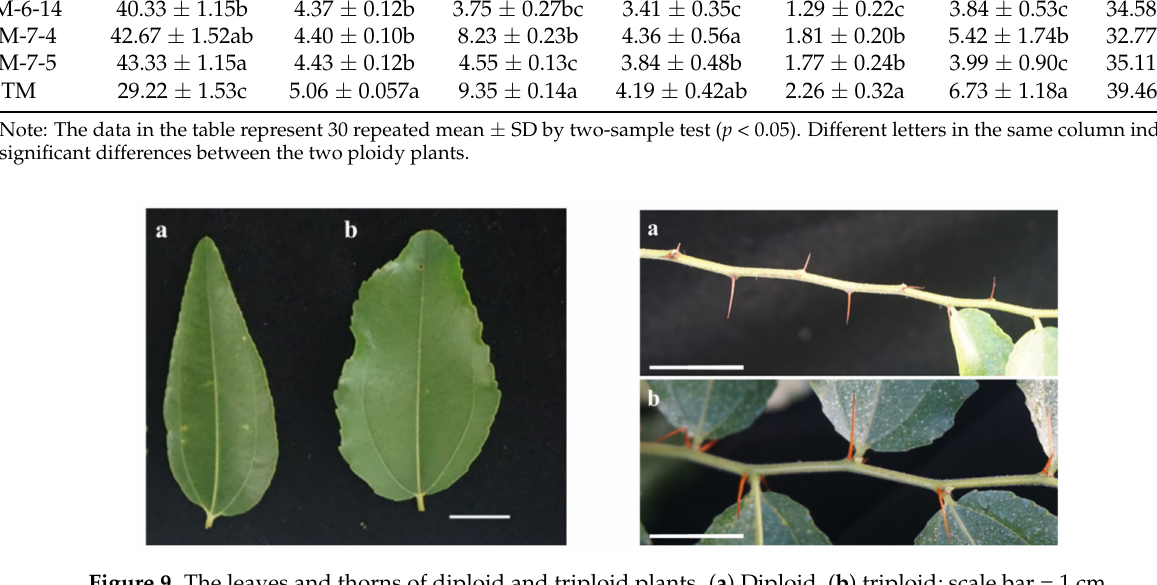
Figure 9. The leaves and thorns of diploid and triploid plants. ( a ) Diploid, ( b ) triploid; scale bar = 1 cm. Table 7. Comparison of photosynthetic characters between diploid and triploid plants. Ploidy.